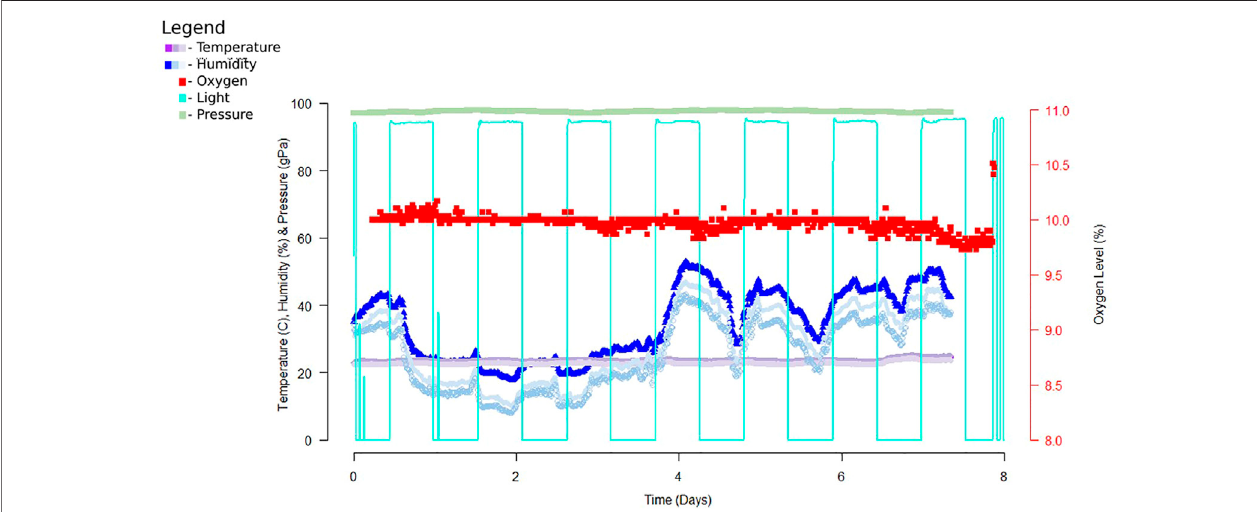
FIGURE3 | Exampledata from a7-day exposureof the chamber. Data wasrecorded using aPython script then analyzed with Rstudio. The data recorded above reports data collected from early experiments utilizing DHT22, ADS1115 and Teledyne oxygen sensor, TSL2591, and MPL3115A2. For this dataset we recorded data every 10 minutes for the entire 7 day exposure time. Since completion of this sampling we replaced these sensors with sensors of higher accuracy and precision.